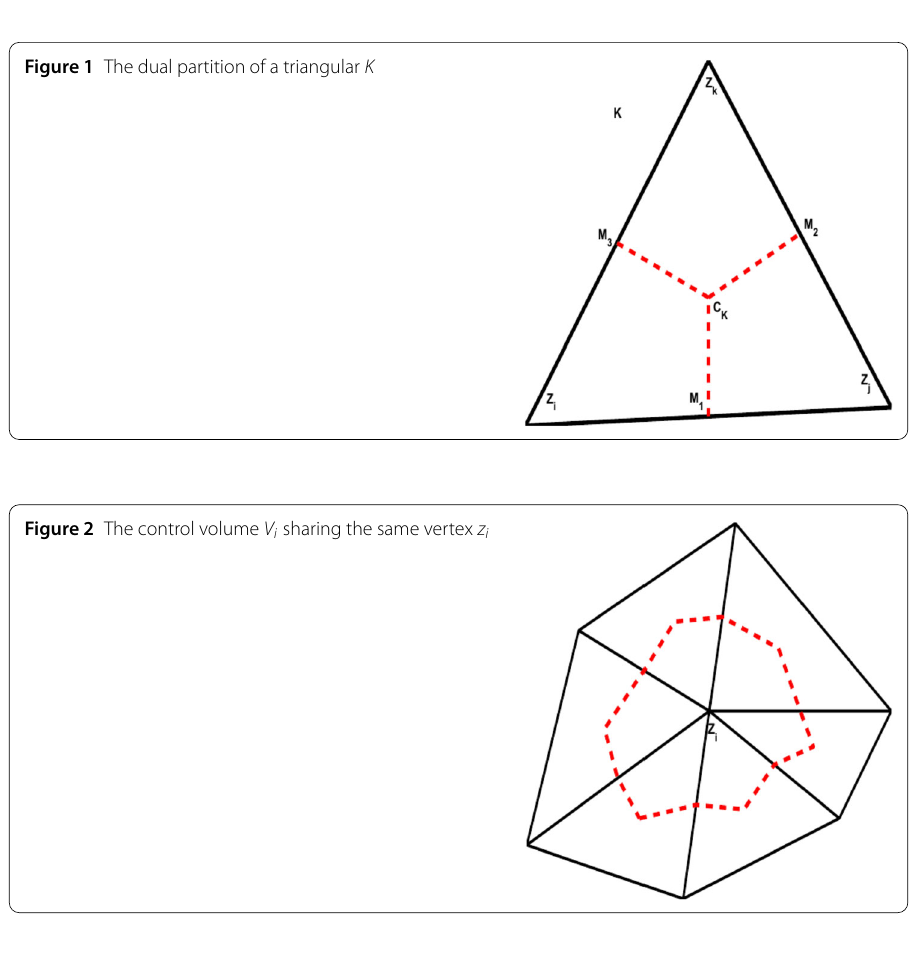
Figure 1 The dual partition of a triangular K